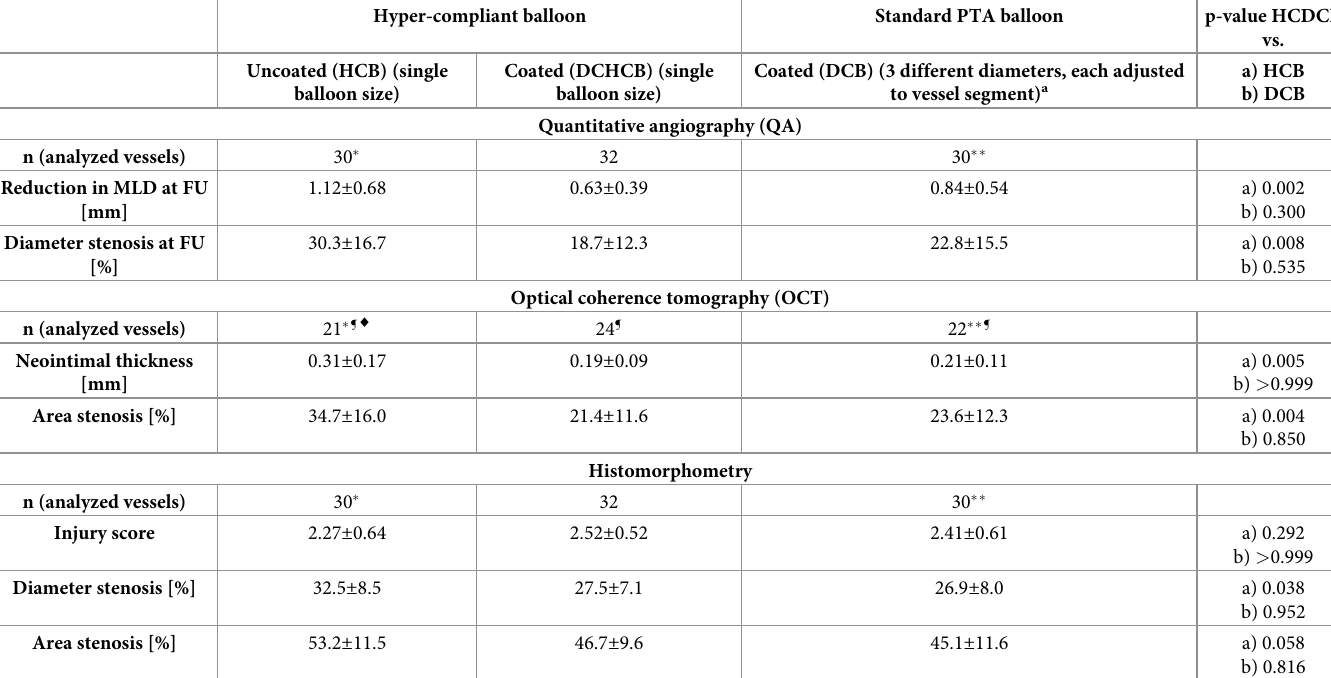
Table 5. Main findings from QA, OCT and histomorphometry at 4-week